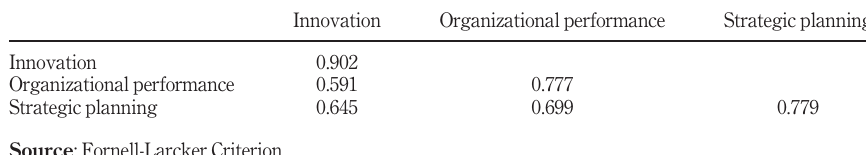
Table IV. Discriminant